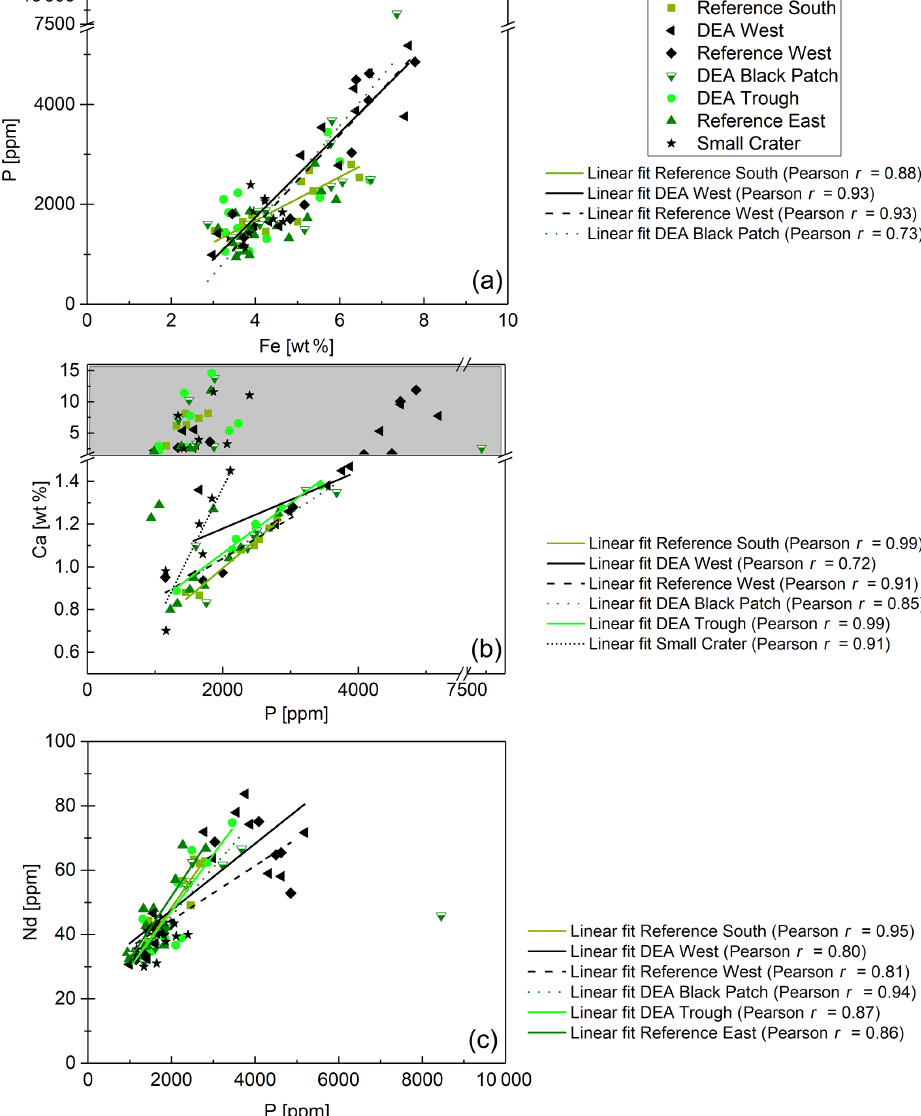
Figure 12. (a) P–Fe correlations for Reference South, DEA West, Reference West, and DEA Black Patch. (b) P–Ca correlations for samples with Ca concentrations below 1.5wt%, except for Reference East, where P and Ca do not correlate. Samples with Ca concentrations above 1.5wt% were excluded from the regression analyses because most of the Ca is then not bound in Ca phosphates. (c) P–Nd correlations for all samples, except for Small Crater, where P and Nd do not correlate, and excluding the DEA Black Patch sample, which has exceptionally high P